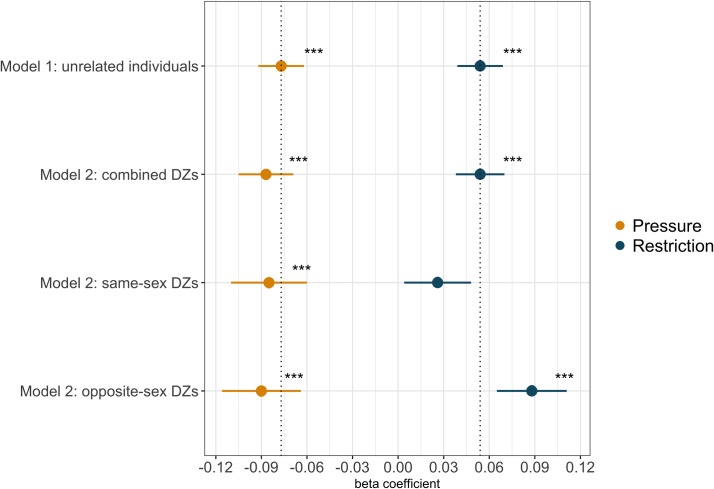
Contrasting results from between-family analyses to results from within-family analyses.Model 1 describes results using BMI GPS of unrelated individuals to predict PFPs, where βGPS indicates the change in the outcome trait per one standard deviation increase in the BMI GPS. Model 2 summarises results using BMI genome-wide polygenic scores in a sample of DZ co-twins using a family fixed-effects model, where βGPS indicates the increase in PFPs within DZ pairs, per one standard deviation increase in BMI GPS within DZ pairs. Model 2 analyses were performed using the combined DZ sample, and same-sex DZ pairs and opposite-sex DZ pairs only. The dotted lines represent the beta coefficient estimates for Model 1. * = p<0.05; ** = p<0.01; *** = p<0.001.